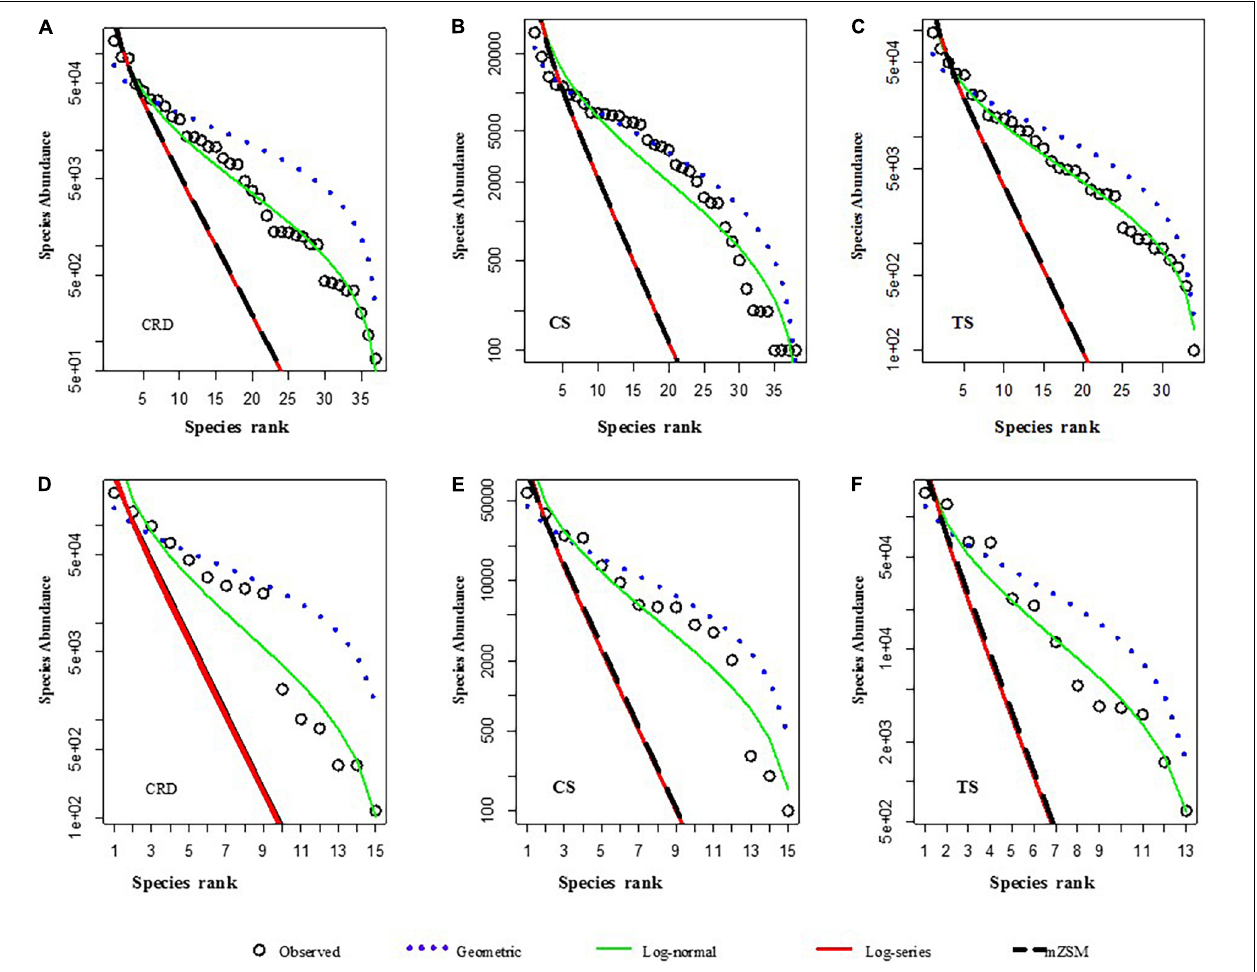
FIGURE 5 | Species abundance distribution (A–C) and LOD size-class abundance distribution (D–F) of tintinnid populations in the CRD, CS, and TS. For species abundance distribution, the geometric distribution gave the best fit in CS (B) , and the log-normal distribution provided the best fit for the CRD (A) and TS (C) . For LOD size-class abundance distribution, the geometric distribution gave the best fit in the CS (E) , and the log-normal distribution provided the best fit for the CRD (D) and TS (F) . Actual observed abundances are shown in circles, and lines are the expected abundance from 4 theoretical distributions, MZSM: meta-community zero-sum